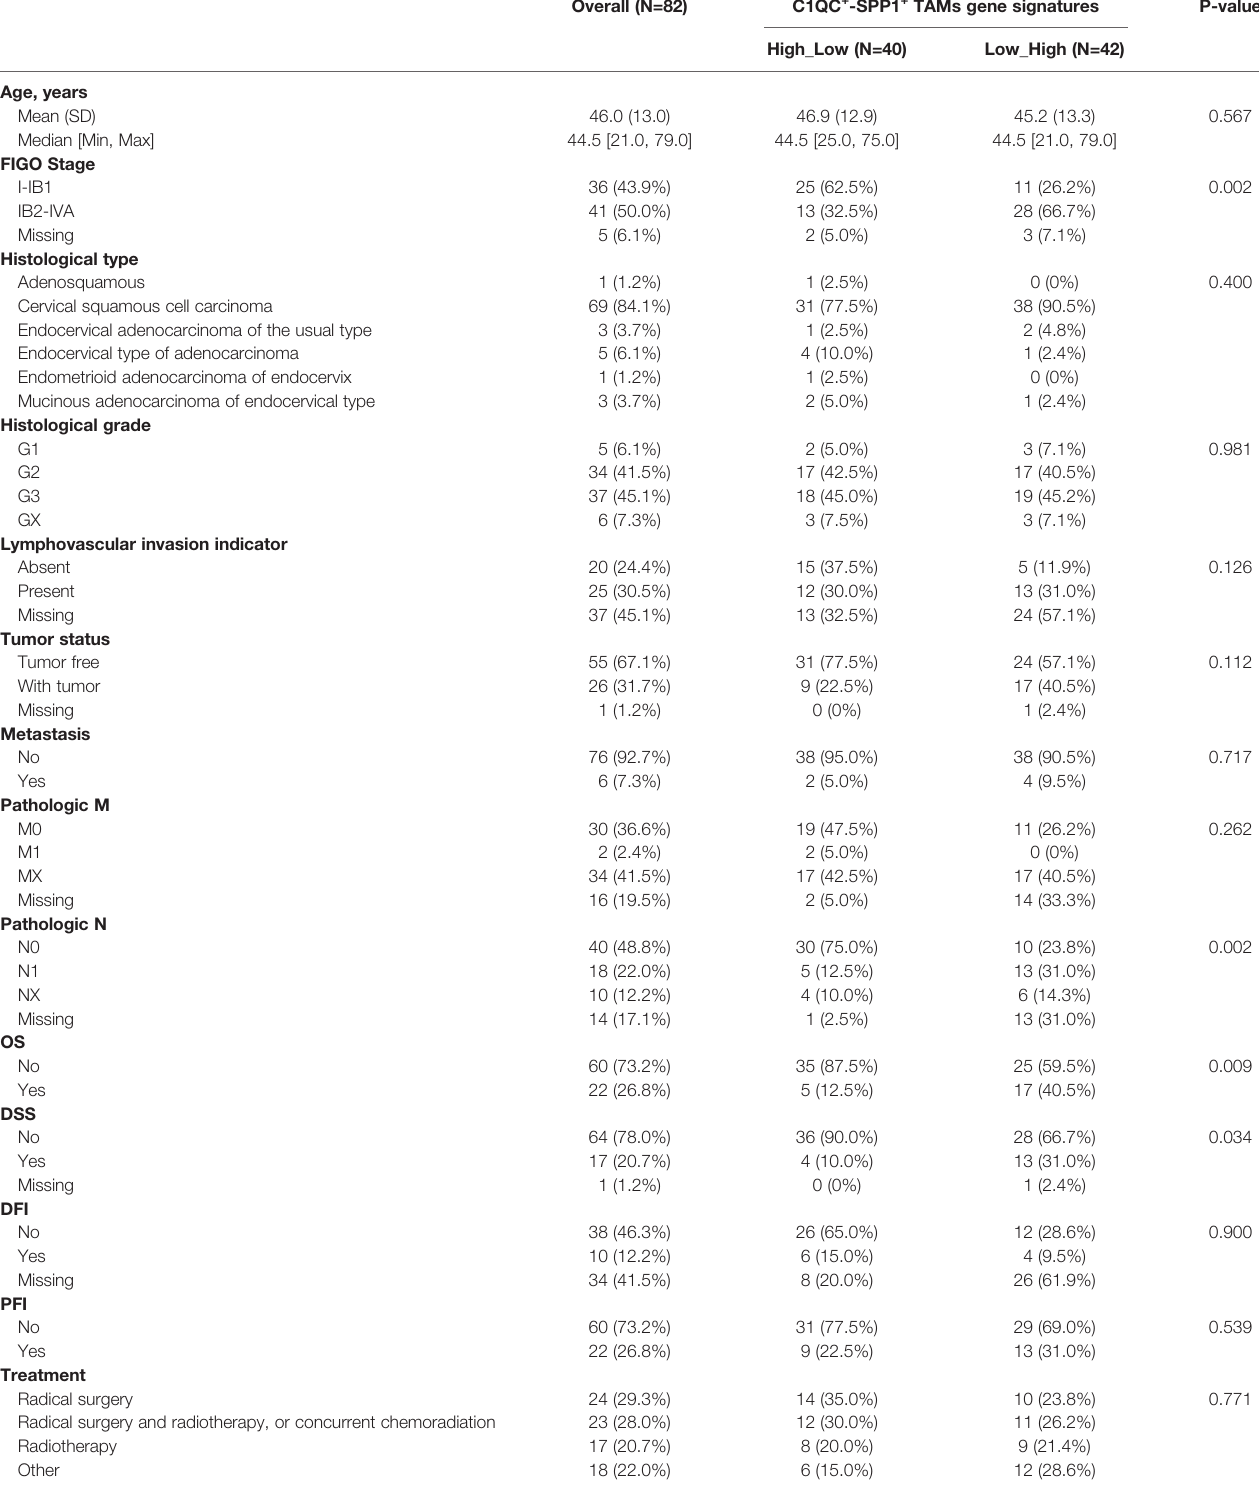
TABLE 1 | Clinicopathological factors of cervical cancer patients from